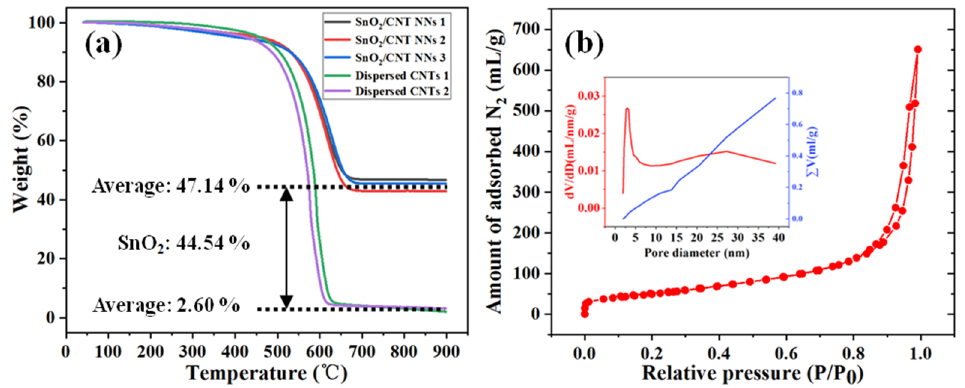
Figure 5. ( a ) TGA curve of SnO 2 /CNT NNs composites in air. flow rate 20 mL min − 1 , heating rate 15 ℃ min − 1 , ( b ) N 2 adsorption/desorption isotherm of the SnO 2 /CNT NNs composites, inset shows the porosity distribution by the Barrett-Joyner-Halenda (BJH) method.